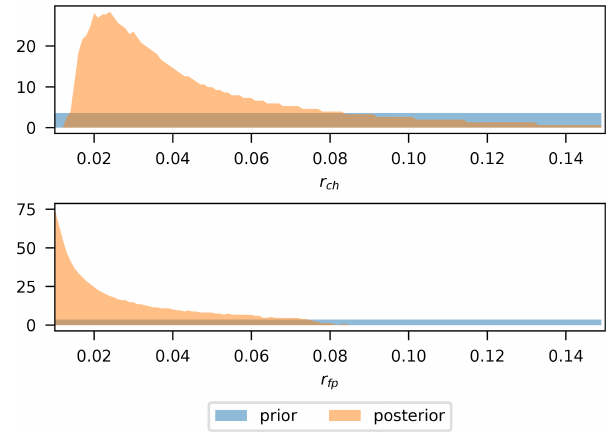
Figure 7. Marginal prior and posterior distribution of parameters for Model 1.